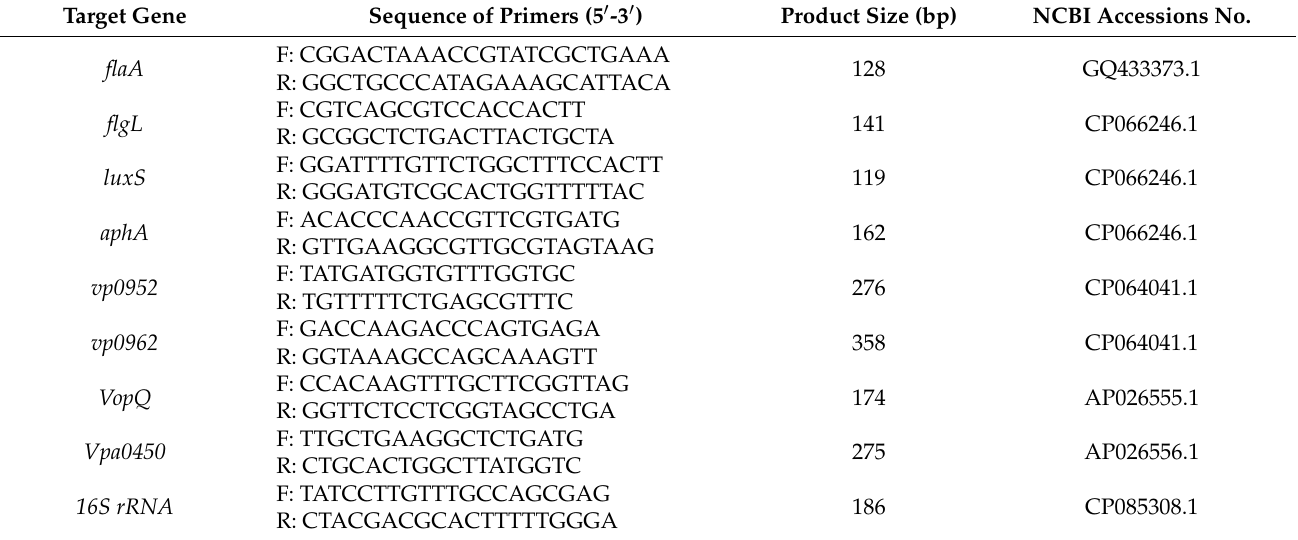
Table 1. Primer lists used in this study for RT-qPCR. F and R stand for forward and reverse primers. Target Gene Sequence of Primers (5 (cid:48) -3 (cid:48)